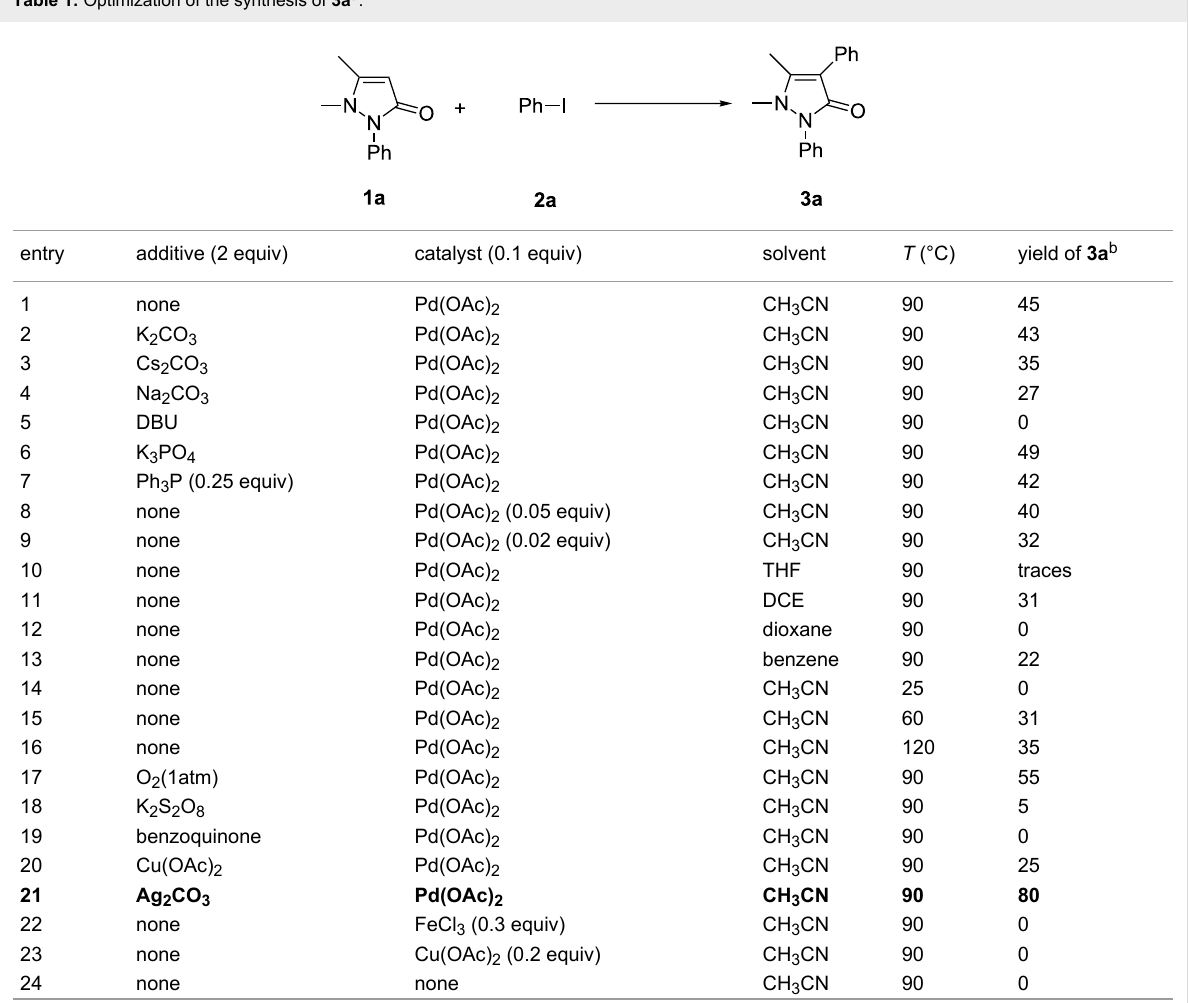
Table 1: Optimization of the synthesis of 3a a